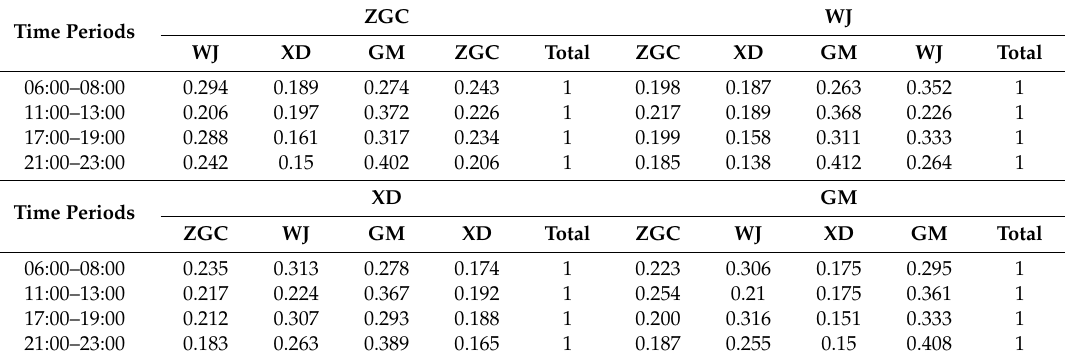
Table 5. Temporal variations of functional regions’ interactions based on O/D